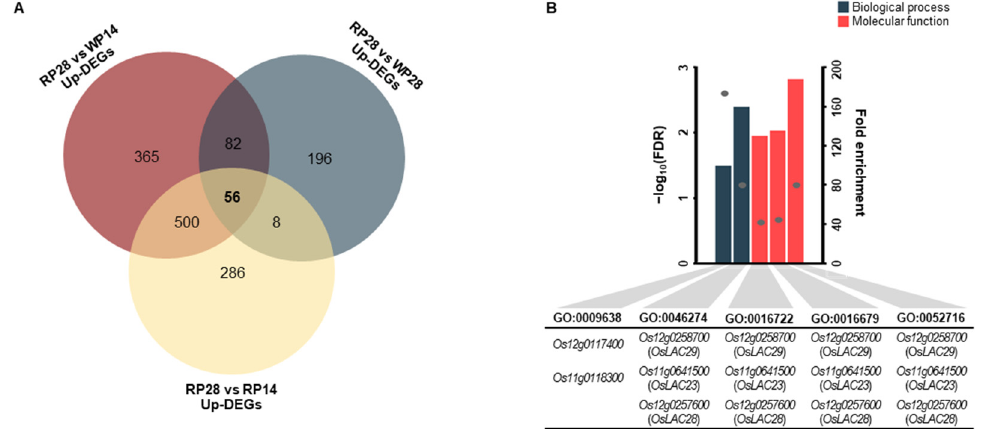
Figure 5. Analysis of RP28-specific upregulated differentially expressed genes (DEGs). Venn dia- gram ( A ) of the upregulated DEGs in RP28 vs. RP14, RP28 vs. WP14, and RP28 vs. WP28. GO enrichment analysis ( B ) of RP28-specific upregulated genes. GO:0009638, phototropism; GO:0046274, lignin catabolic process; GO:0016722, oxidoreductase activity, acting on metal ions; GO:0016679, oxidoreductase activity, acting on diphenols and related substances as donors; GO:0052716, hydro- quinone:oxygen oxidoreductase activity. Bar charts represent the –log 10 false discovery rate (FDR) of enriched GO terms with an FDR of <0.05, and the gray dots denote fold enrichment.